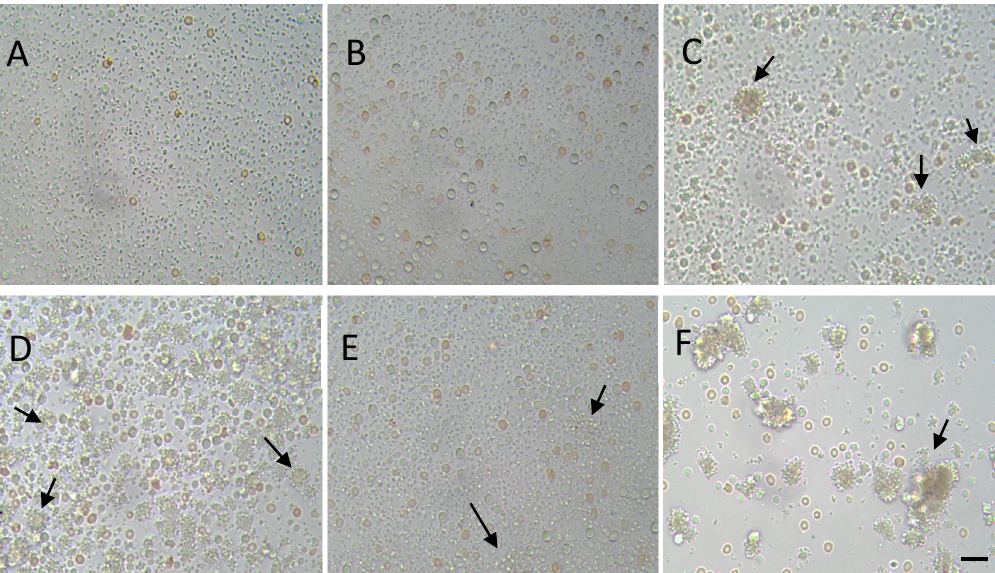
Figure 5. Phase-contrast micrographs of unstimulated ( A – C ) and ADP-stimulated ( D – F ) platelets, treated with nGO ( B , E ) and nGO-PEG ( C , F ) NPs. A quantity of 100 μ g/mL of nGO and nGO-PEG nanoparticles were co-incubated with platelet-rich plasma and pplatelet activation was induced by addition of 50 μ M/mL of adenosine diphosphate (ADP). Arrows show platelet aggregates. Scale bar: 20 μ m.